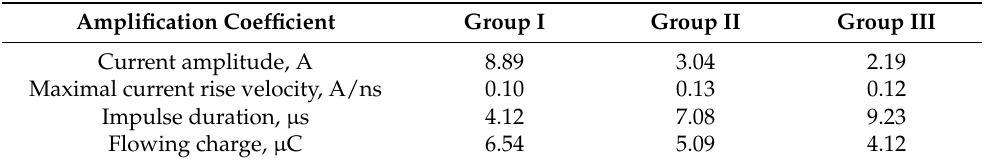
Table 2. Characteristics of the current impulse of streamer corona on the cylinder model elements (average values).